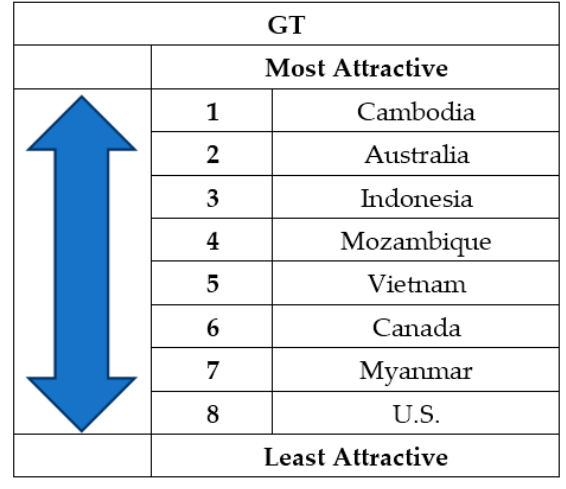
Figure 2. Attractiveness Rank of Eight Countries by GT.